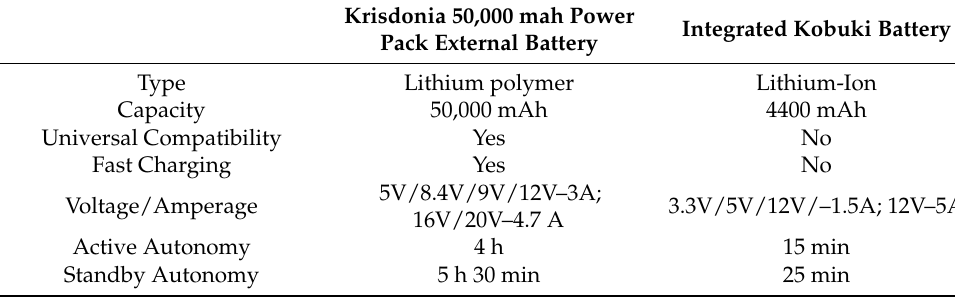
Table 4. Comparison of batteries used to power all components of the robot.